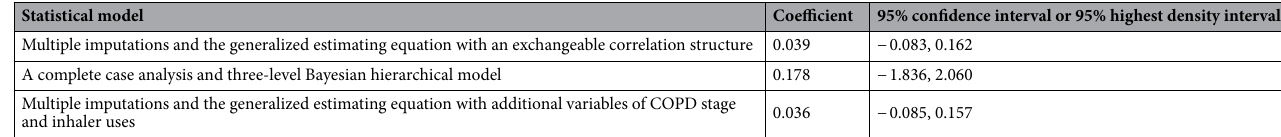
Table 3. The estimated difference in the length of the hospital stay between the anti-pseudomonal and non- anti-pseudomonal antibiotics groups. COPD Chronic obstructive pulmonary